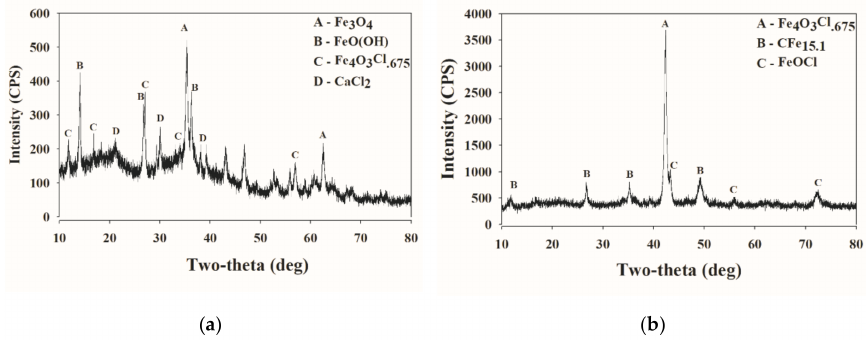
Figure 7. ( a ) XRD analysis of specimen B, ( b ) XRD analysis of specimen C.